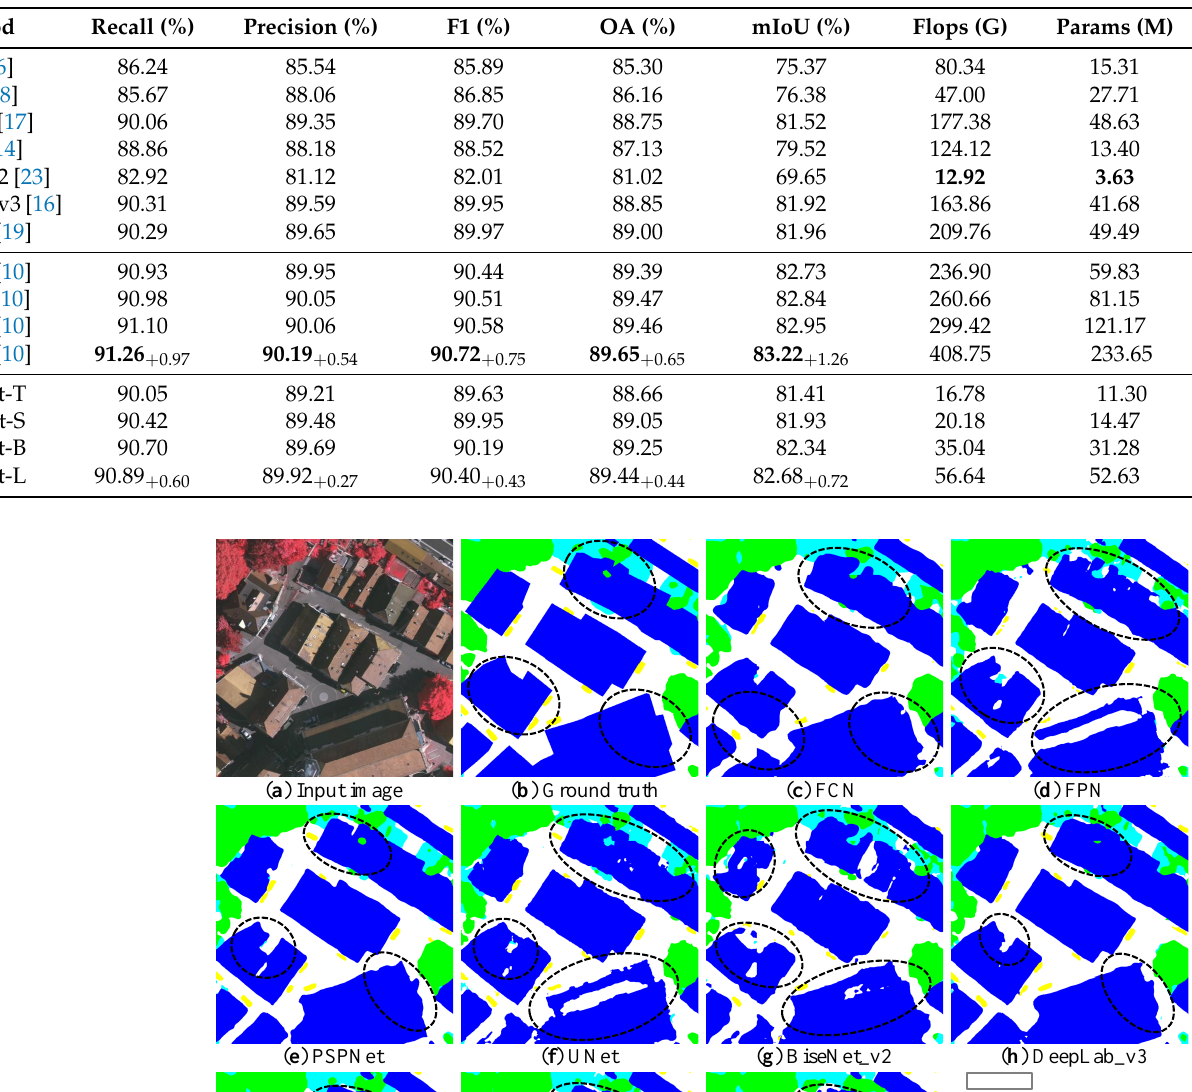
Table 11. Comparison of SOTA methods on the Potsdam dataset.